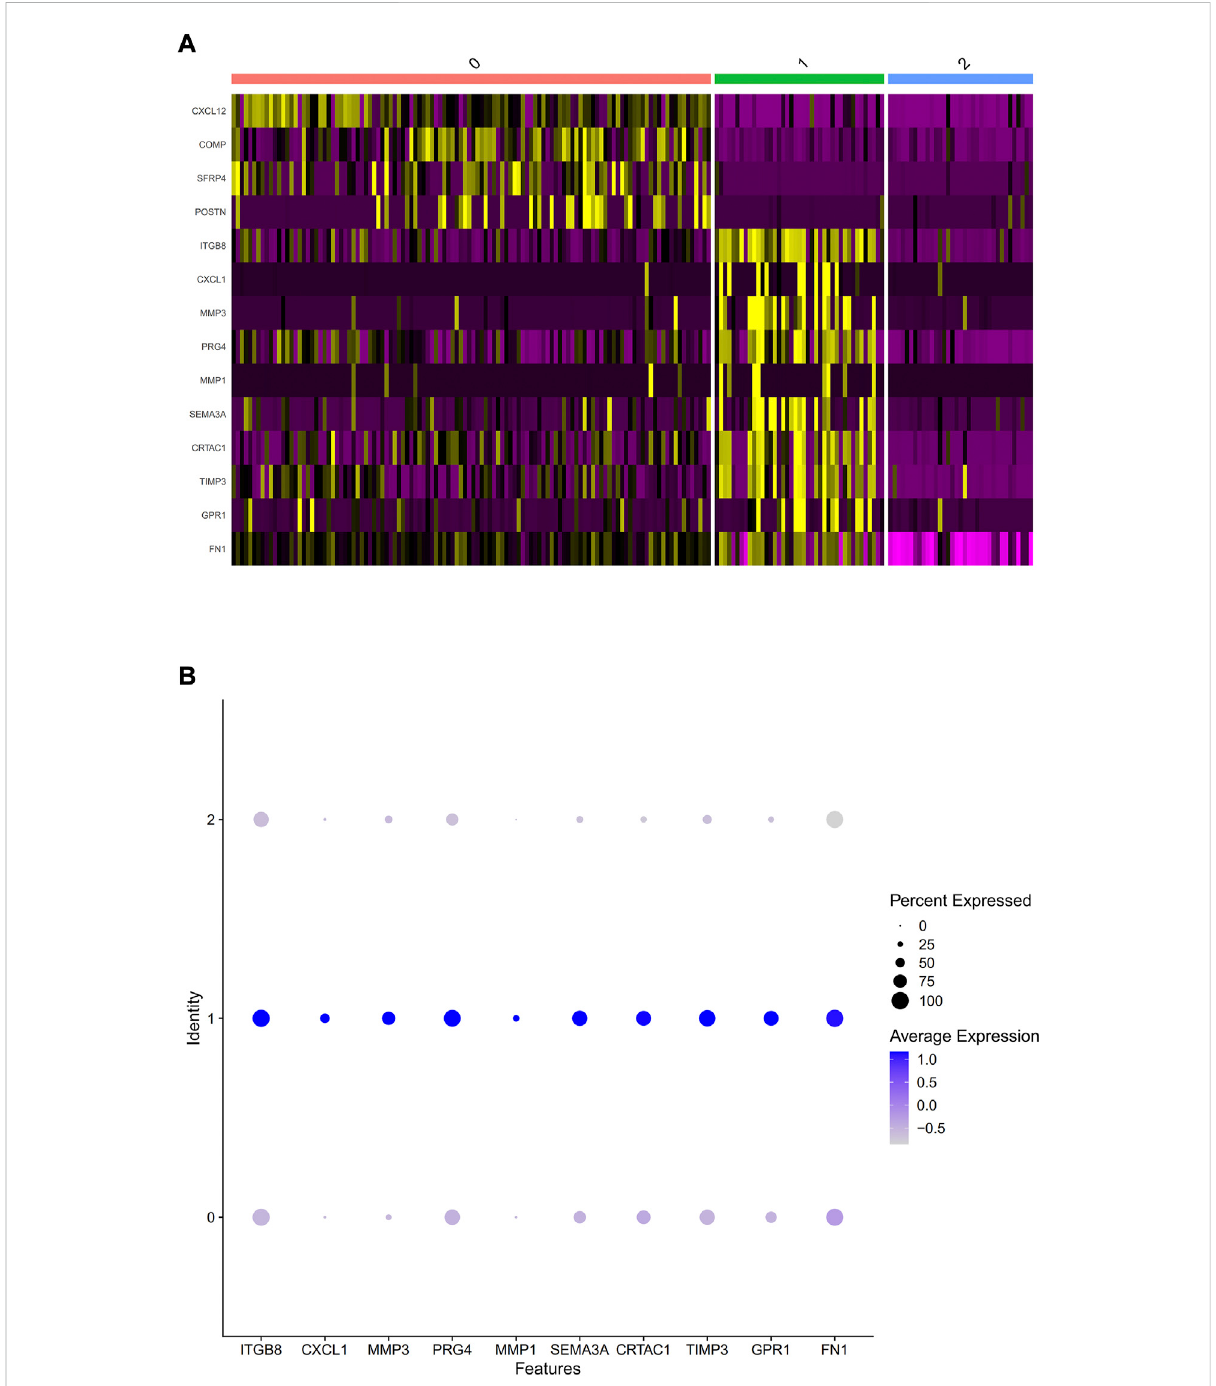
Selection of considerably divergent biomarker-genes within TSNE cell-types. (A) A heatmap was used to show differing gene dysregulations within three cell-types, whereby which purple and yellow color depicts downregulated and upregulated genes, accordingly. The abscissa indicates cells oftypes 0,1, and2, whilevertical-axisdisplays normalized biomarkers for three cell-types employingSeurat 3.0. (B) The expression data for ten marker genes in type 1